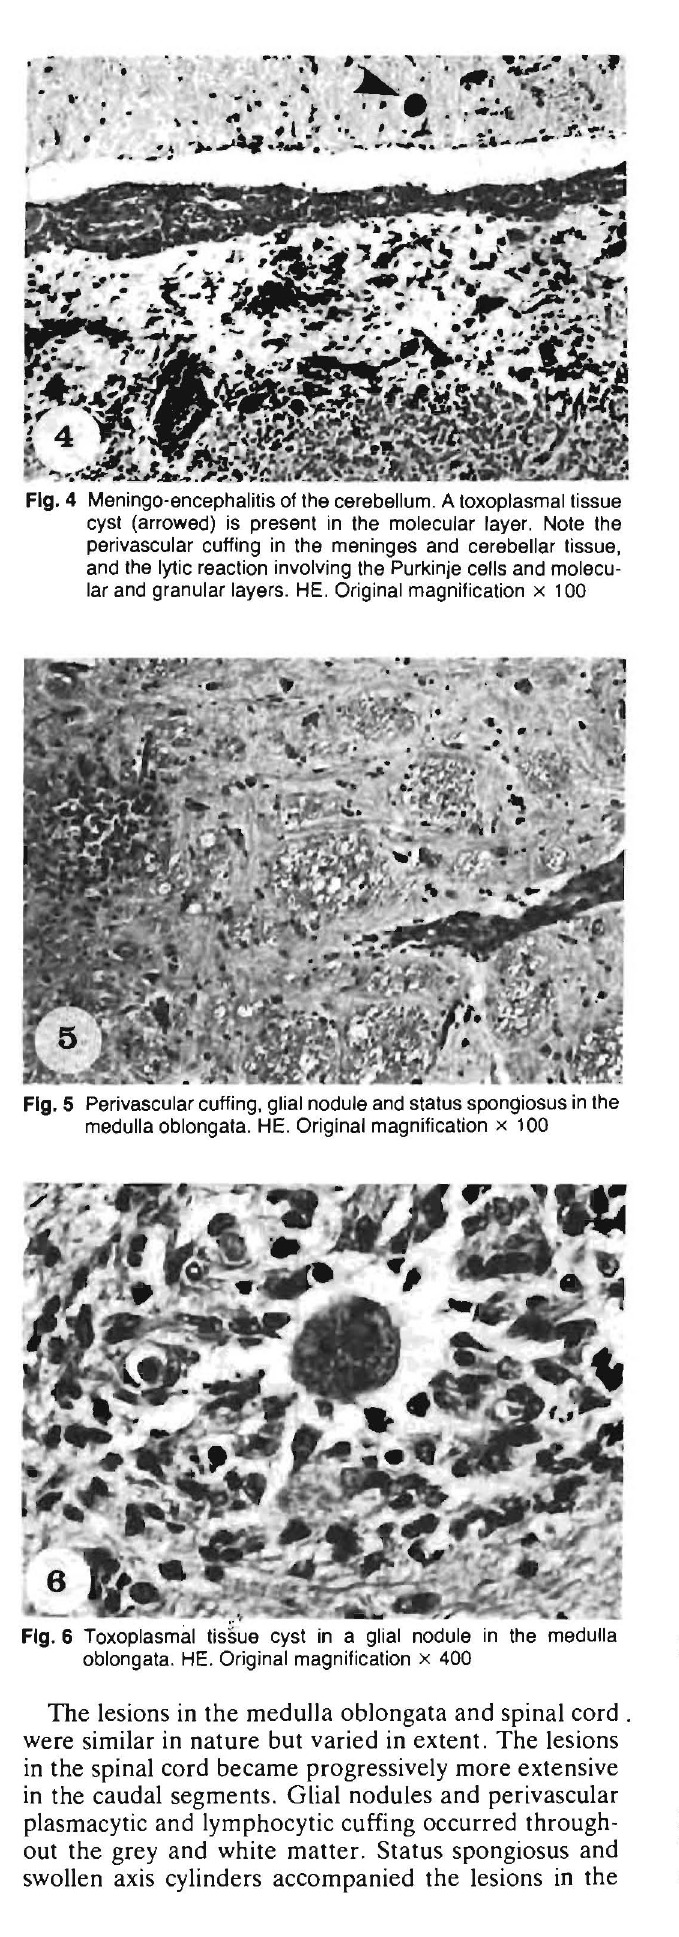
Fig. 6 Toxoplasmal tis§ue cyst in a glial nodule in the medulla oblongata. HE. Original magnification x 400 The lesions in the medulla oblongata and spinal